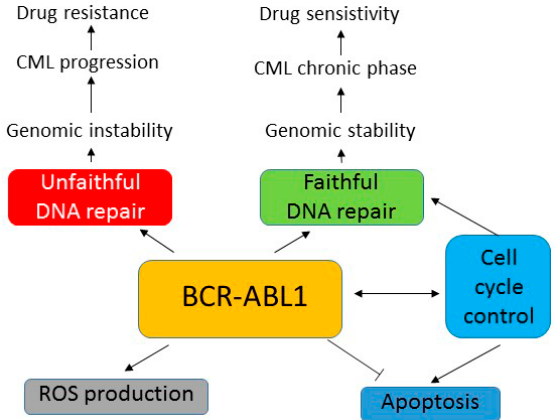
Figure 5. Some aspects of the involvement of BCR-ABL1 in the DNA damage response.